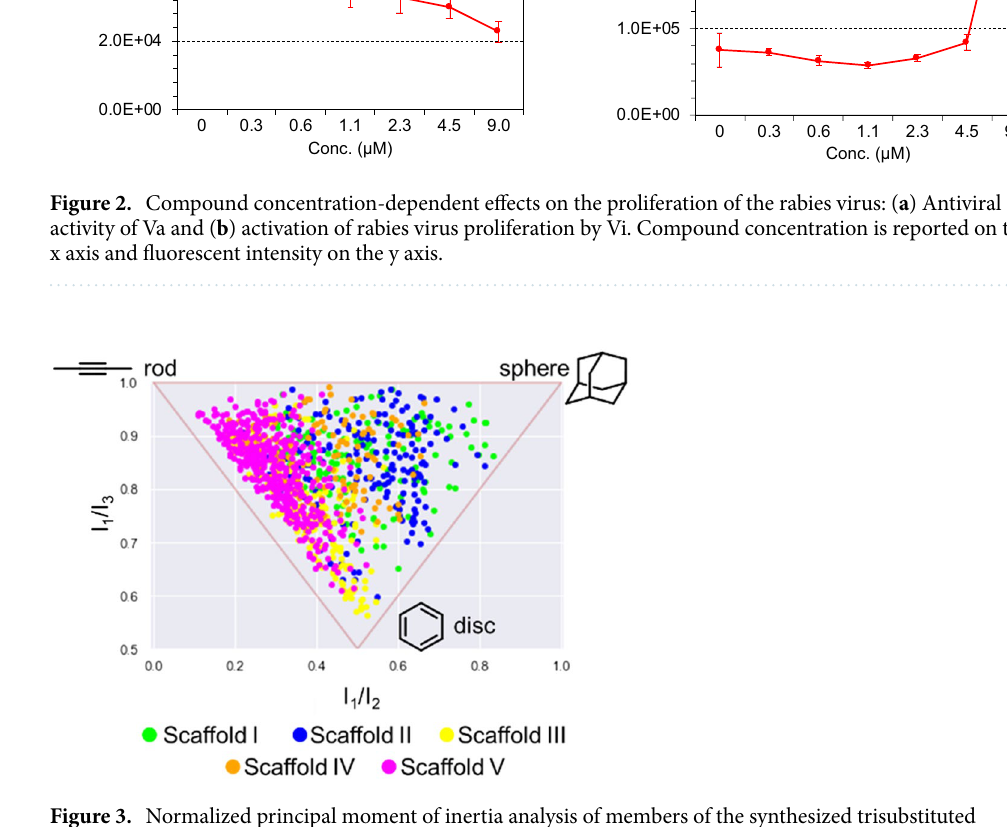
Figure 3. Normalized principal moment of inertia analysis of members of the synthesized trisubstituted carborane library; parameters I 1 /I 2 and I 1 /I 3 were defined by Sauer and Schwartz 53 . These values were calculated with the aid of RDKit 54